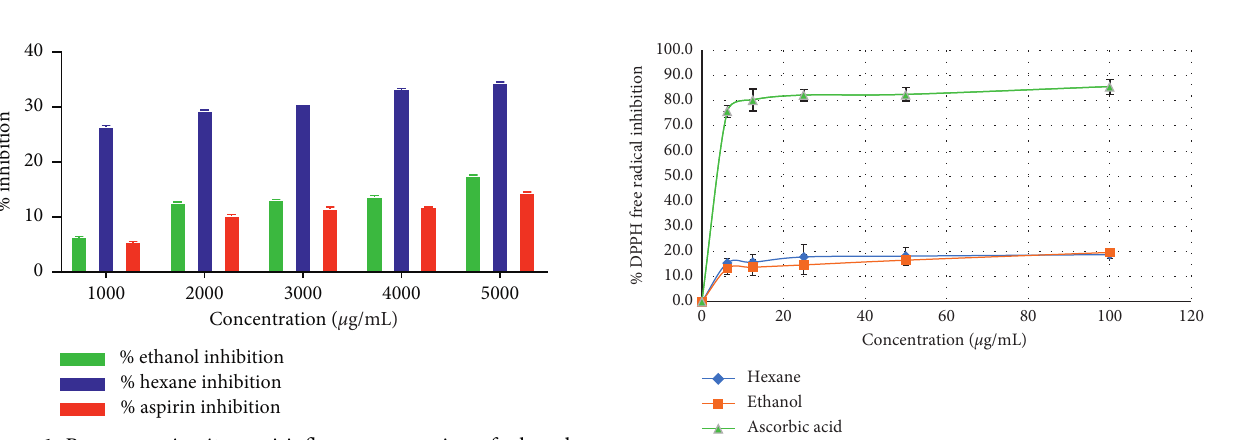
Figure 2: Comparative DPPH radical scavenging activity of the extracts of O. basilicum and ascorbic acid. Table 3: IC 50 of DPPH radical scavenging activity for the ethanol and hexane extracts of O. basilicum and ascorbic acid.